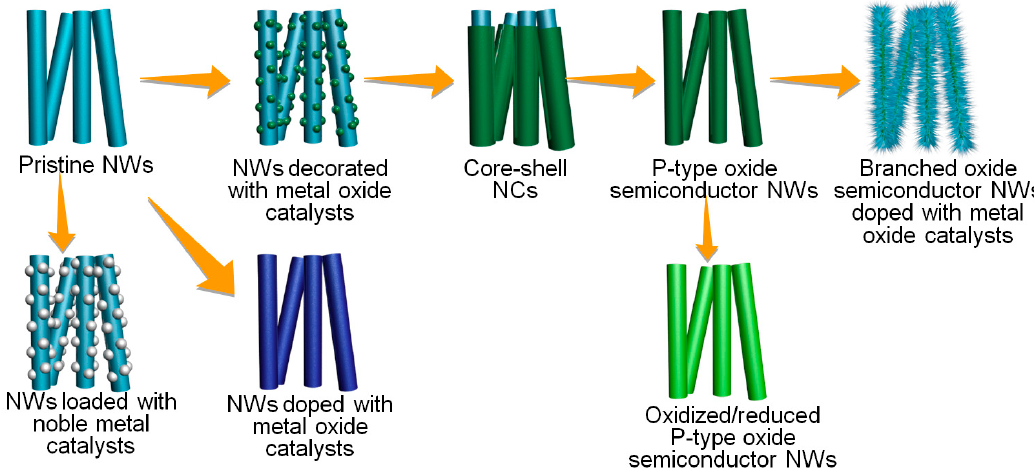
Figure 12. Various oxide nanowires for highly selective gas detection.